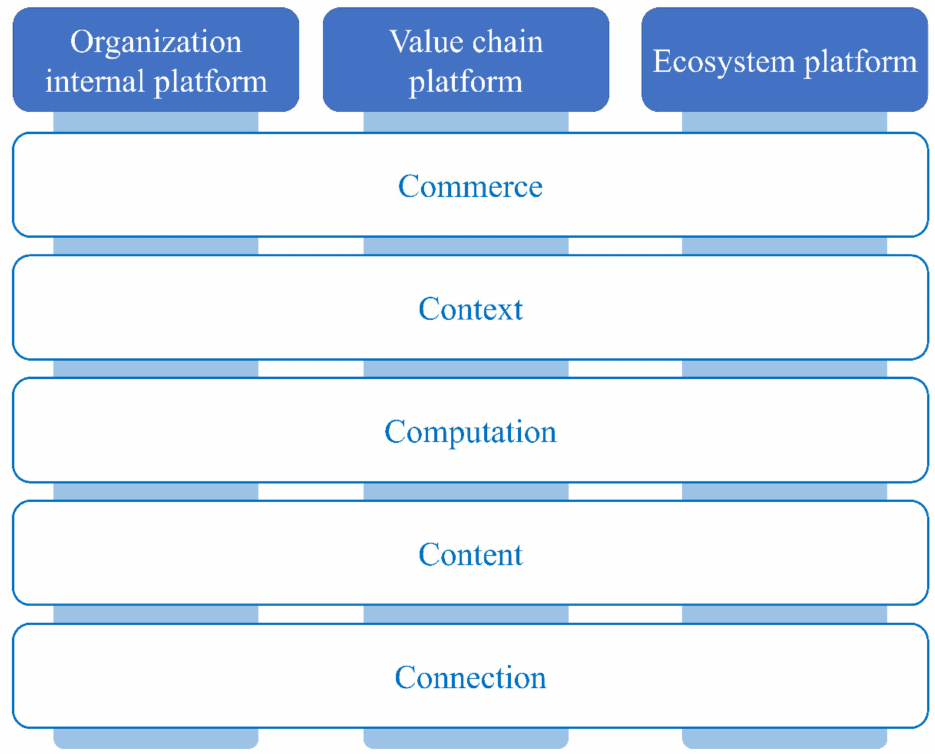
Figure 1. The overall conceptual framework of the